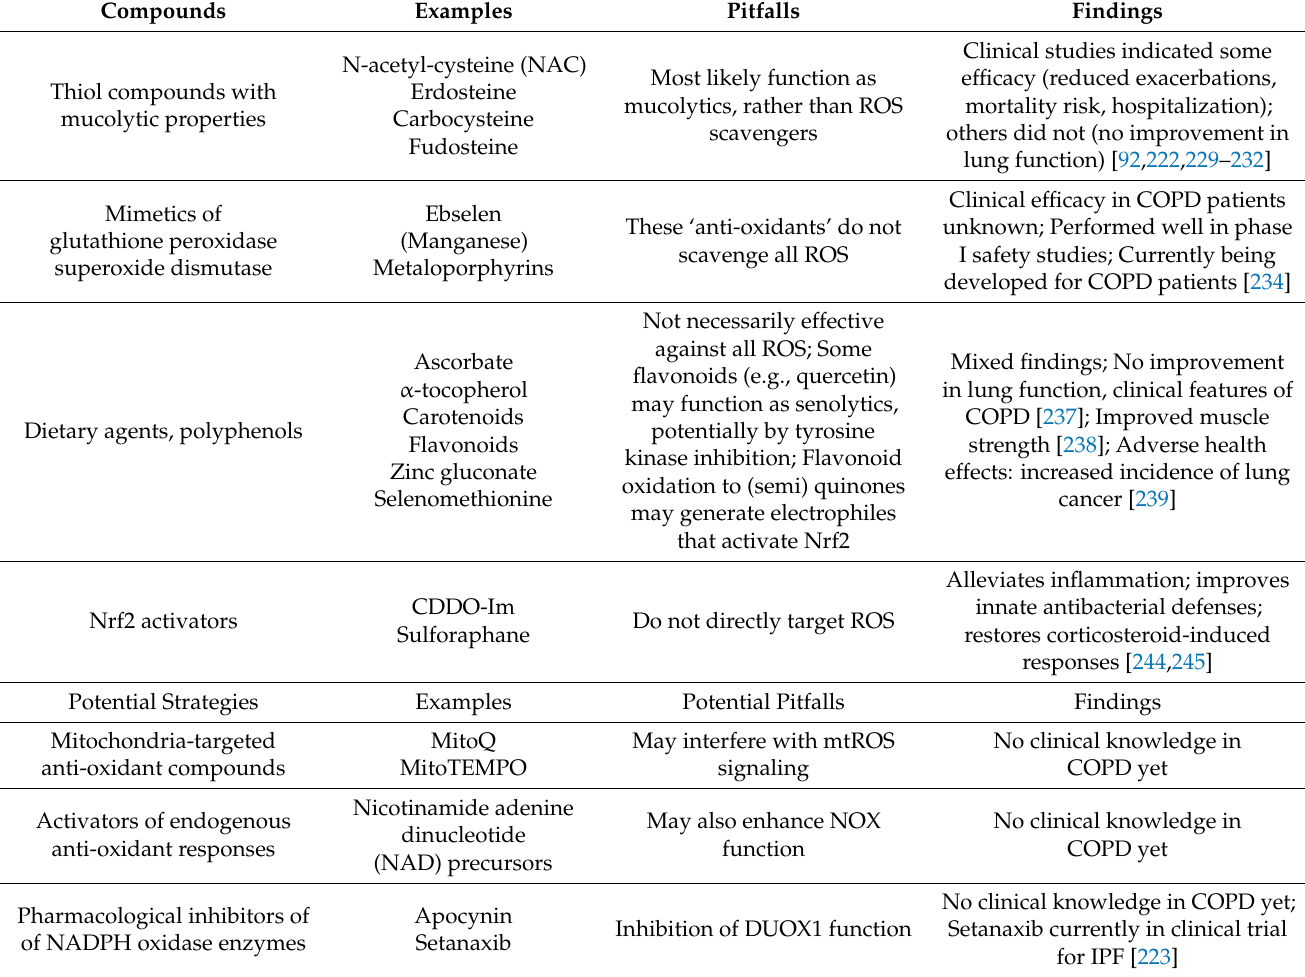
Table 3. Various approaches targeting oxidative stress in COPD that are currently tested for use, and potential novel